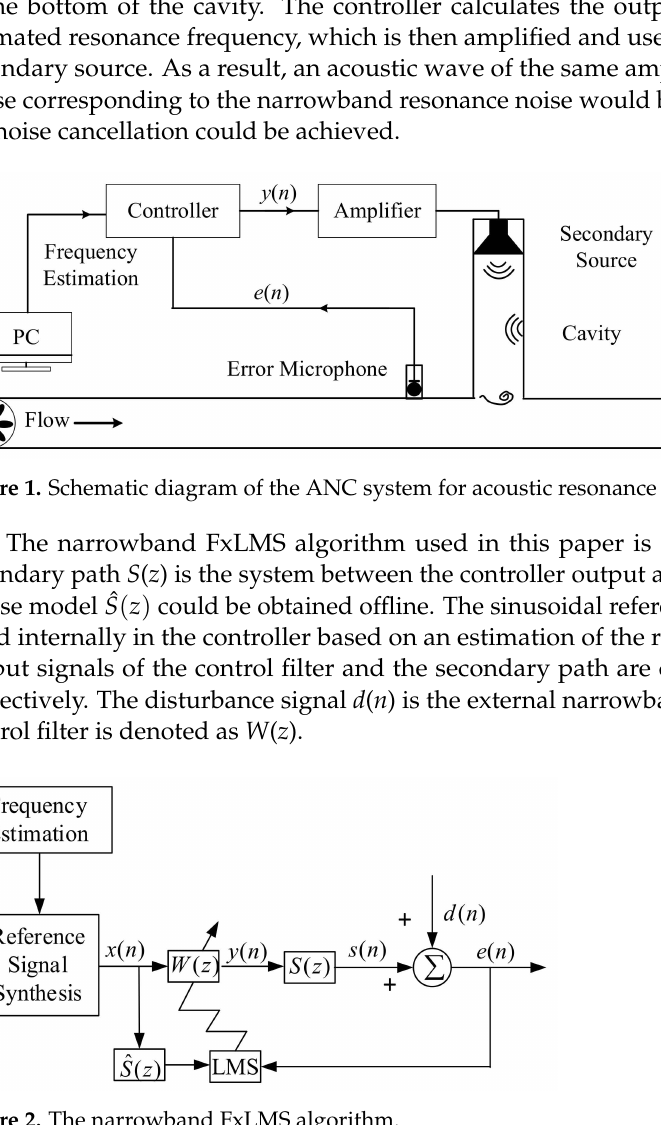
Figure 2. The narrowband FxLMS